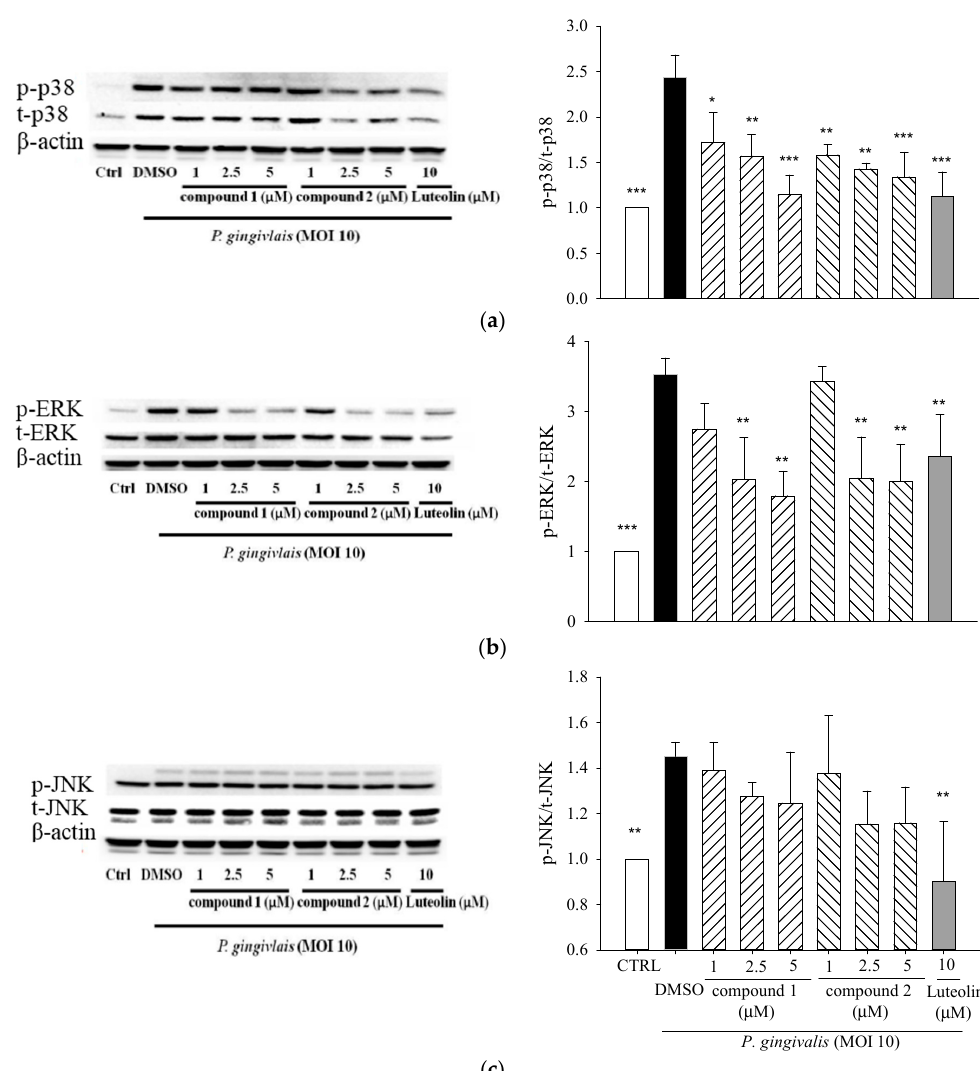
Figure 5. Effects of 5 β ,19-epoxycucurbita-6,23-diene-3 β ,19,25-triol ( 1 ) and 3 β ,7 β ,25-trihydroxycucurbita- 5,23-dien-19-al ( 2 ) on the activations of ( a ) p-38 MAPK; ( b ) ERK; and ( c ) JNK proteins in P. gingivalis -stimulated THP-1 cells. Each column shows the mean ± SD of three independent experiments. * p < 0.05; ** p < 0.01; and *** p < 0.001 vs. DMSO vehicle ( P. gingivalis alone).